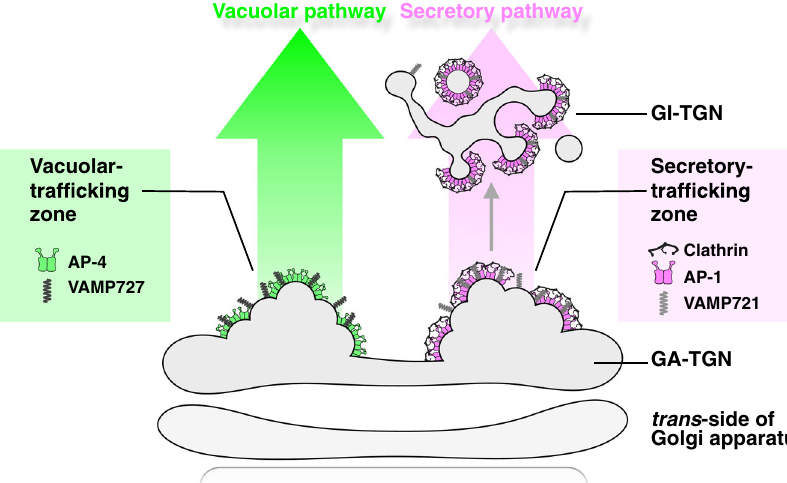
Fig. 7 A schematic model of two distinct traf fi cking zones of the TGN. The Golgi-associated TGN (GA-TGN) has at least two zones, the secretory- traf fi cking zone and the vacuolar-traf fi cking zone, which we propose are responsible for distinct cargo sorting in Arabidopsis root epidermal cells. The secretory-traf fi cking zone consists of R-SNARE VAMP721 (pale gray), adaptor protein AP-1 (magenta), coat protein clathrin (black). The vacuolar- traf fi cking zone consists of R-SNARE VAMP727 (dark gray) and adaptor protein AP-4 (green). From the secretory-traf fi cking zone, some of the TGN detaches as the Golgi-released independent TGN (GI-TGN) in a form of a vesicle/bud cluster including clathrin-coated